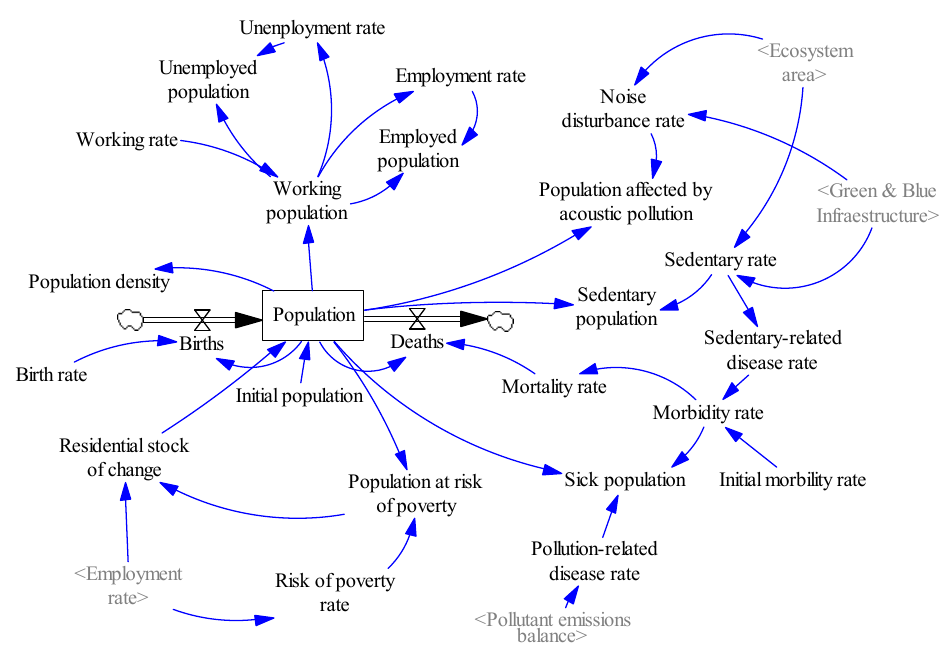
Figure 4. Population system (own elaboration).